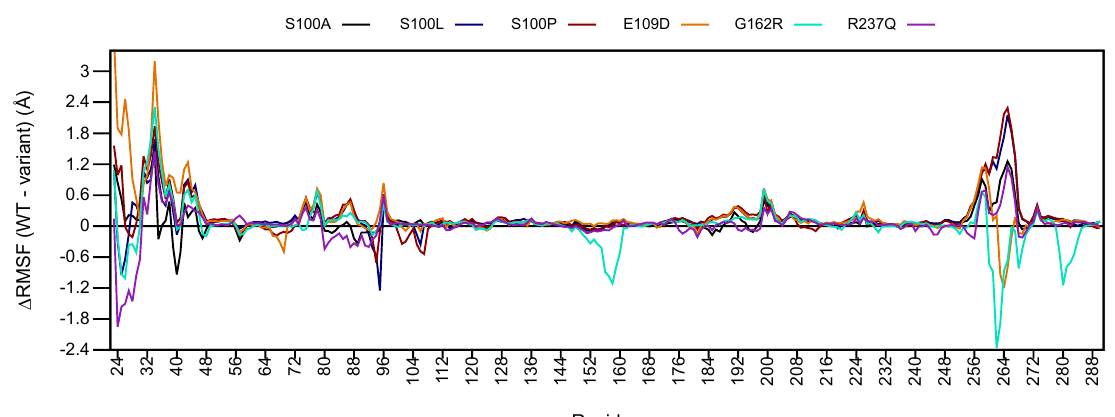
Figure 4. ∆ RMSF (WT − variant) comparison of WT and variant proteins. Respective CA-VIII secondary structure is shown as colour coded bars at the bottom of the plot. Red: α -helix; Blue: β